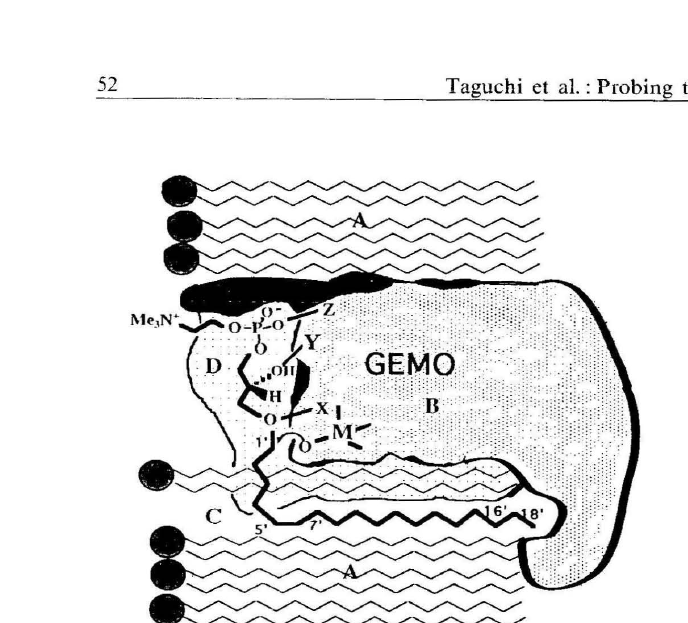
Figure 1. Proposed model for the active site of Glyceryl ether monooxygenase (GEMO) A = lipid layer, B = protein, C = hydrophobic pocket, 0 = hy drophilic